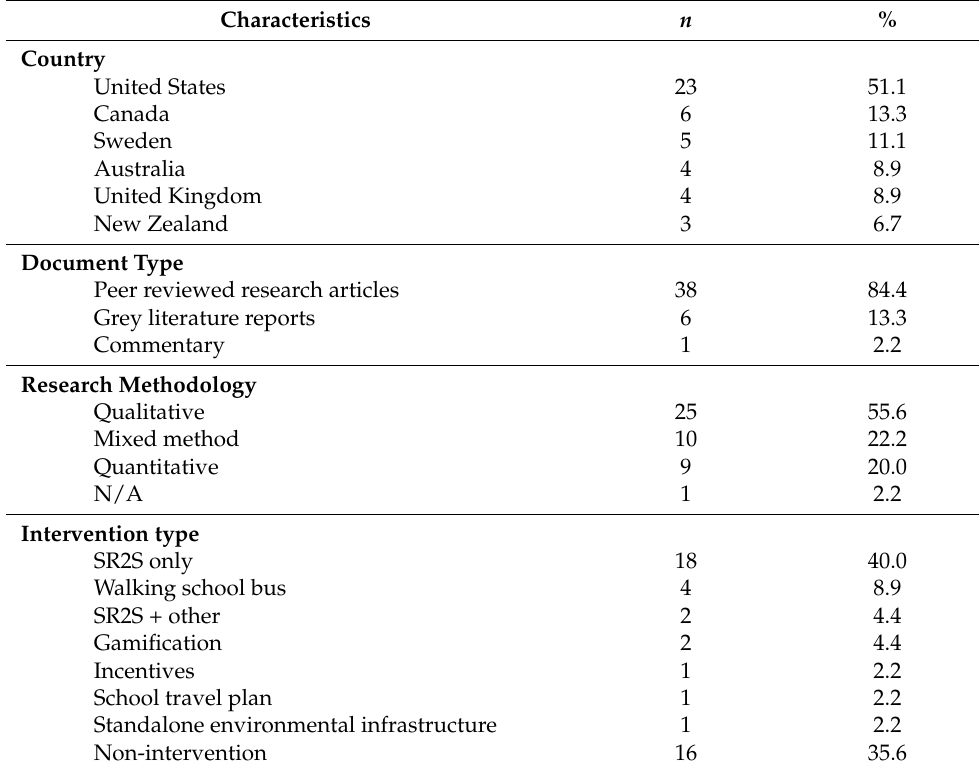
Table 2. Characteristics of Documents Included in this RRR ( n =